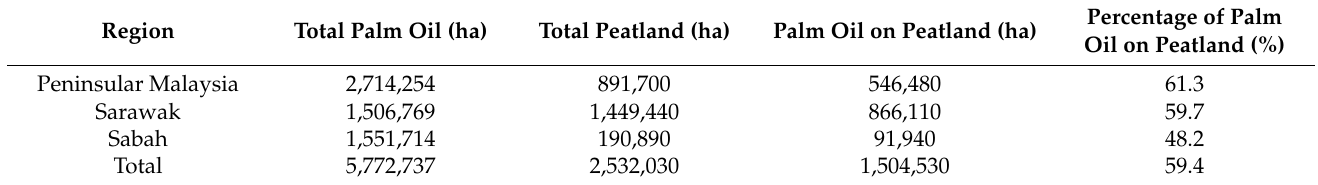
Table 3. Palm oil and palm trees on peat land areas (2016) (Source: